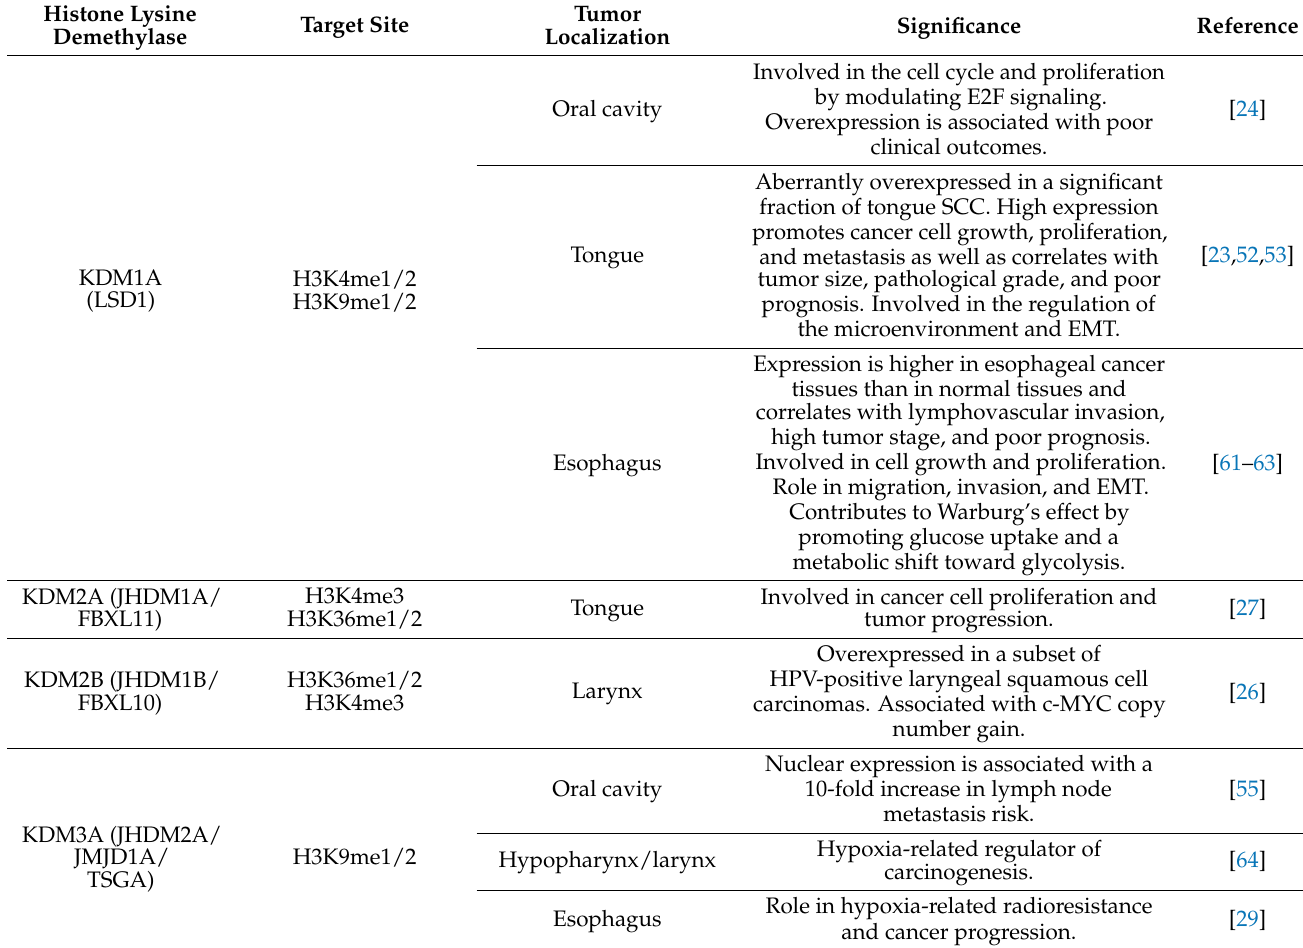
Table 1. The role of histone lysine demethylases in head and neck cancers. Histone Lysine